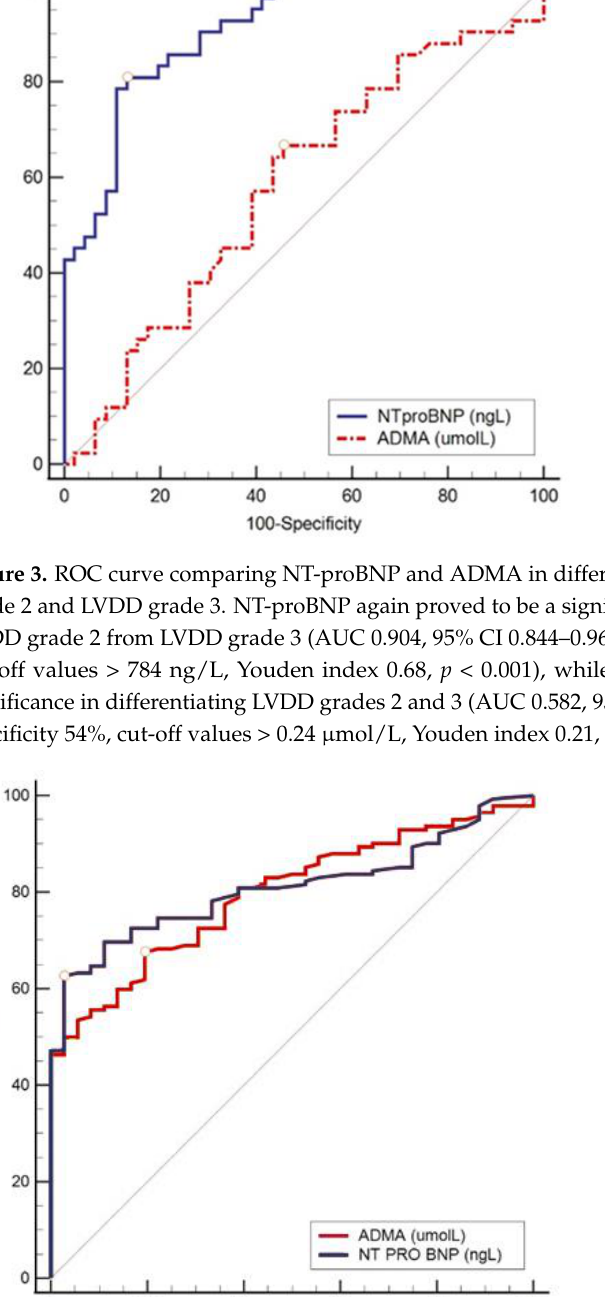
Figure 4. ROC analysis in predicting the laboratory values of ADMA and NT-proBNP using more clinically accessible parameters used for SCORE2. ADMA used the following parameters: AUC 0.796, 95% CI 0.730 – 0.853, sensitivity 97.6% and specificity 80.6% at cut- off values ≤ 0.475 µmol/L, Youden index 0.482, p < 0.001. NT-proBNP had the following parameters: AUC 0.810, 95% CI 0.744 – 0.865, sensitivity 62.7% and specificity 97.2% at cut-off values > 0.136 ng/L, Youden index 0.599, p < 0.001.